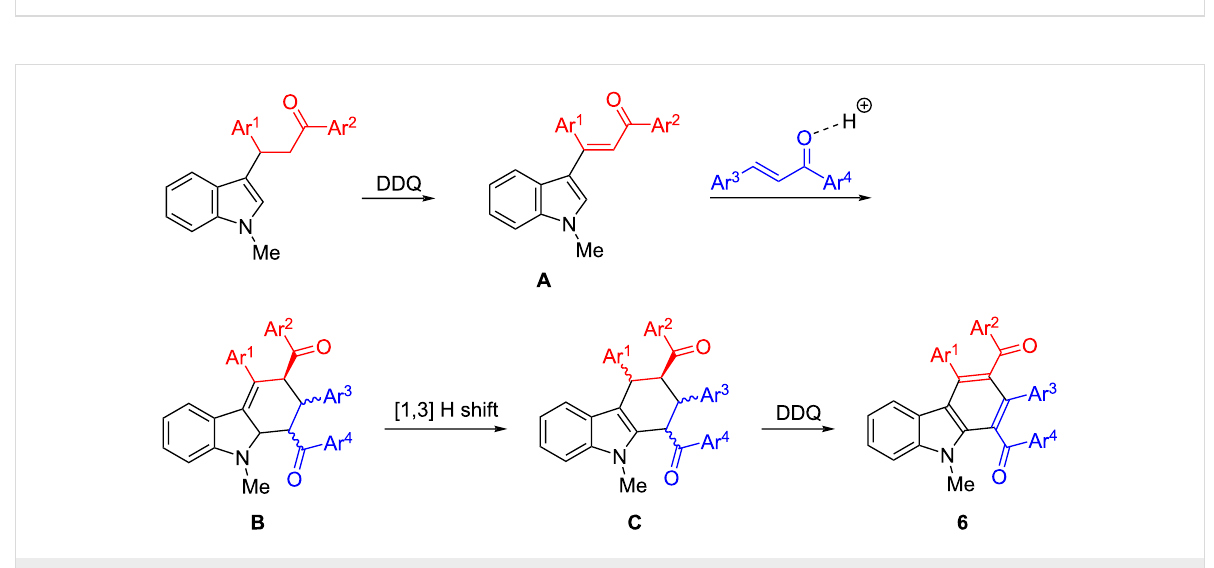
Scheme 2: Proposed domino reaction mechanism for the formation of carbazoles 6